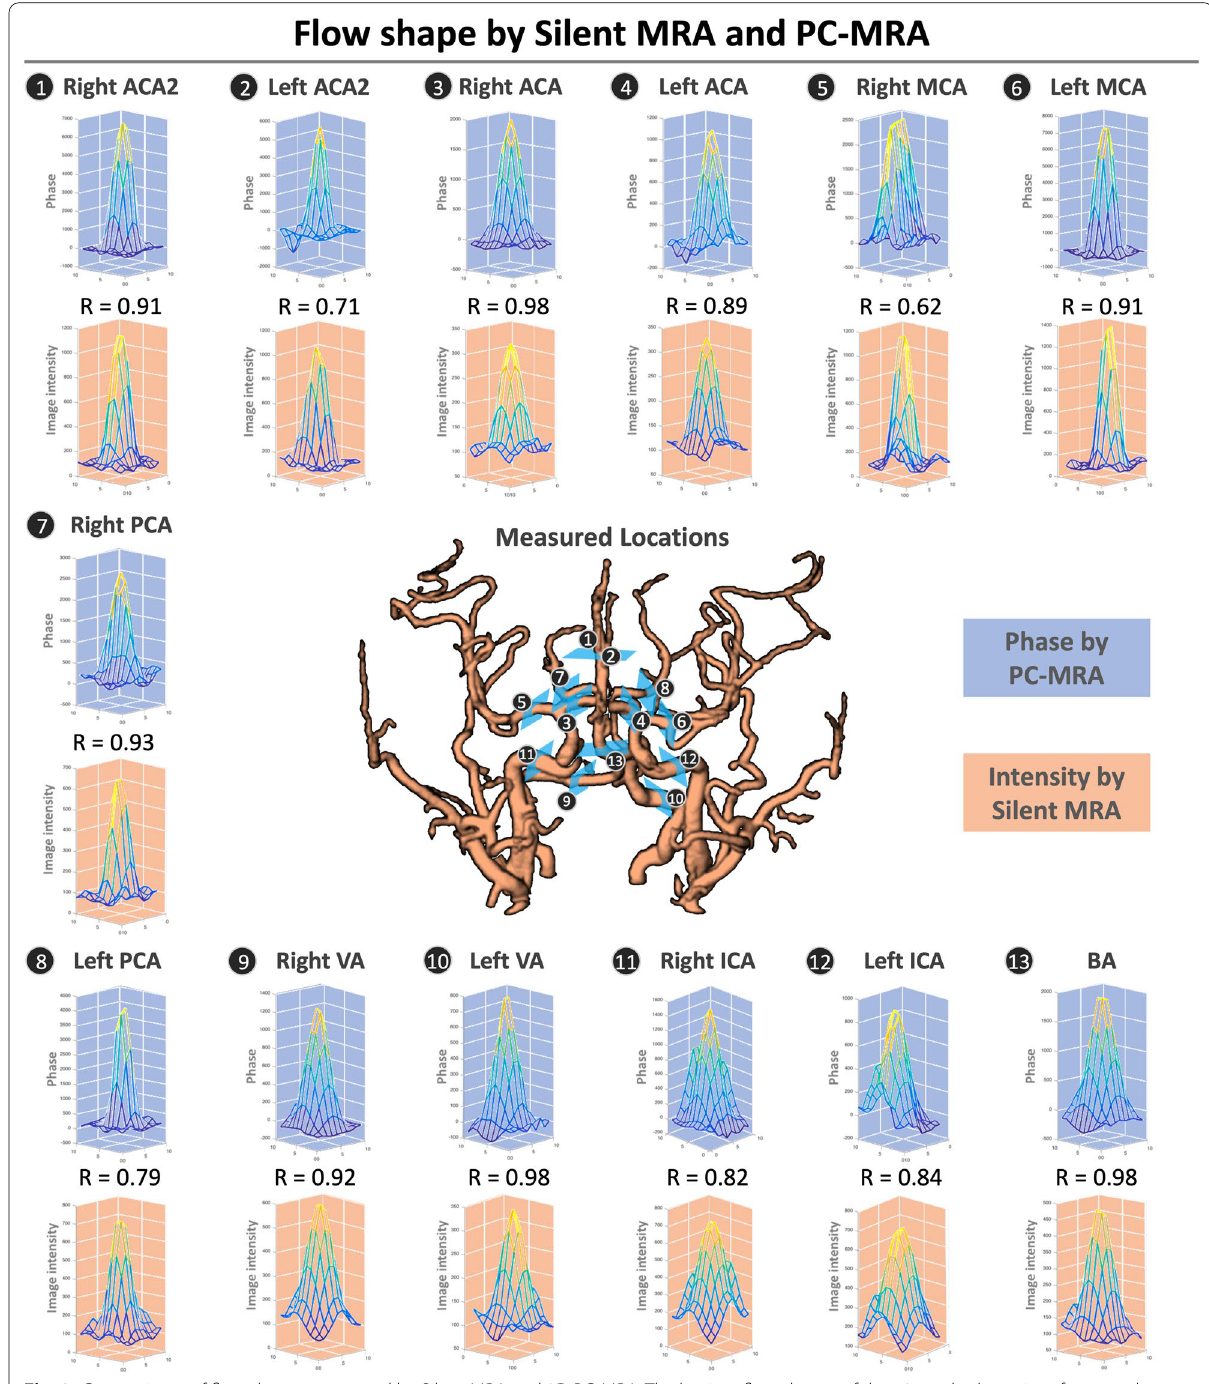
Fig. 3 Comparisons of flow shapes generated by Silent MRA and 2D PC‑MRA. The laminar flow shapes of the 13 cerebral arteries of one study participant (33‑years‑old; man) are similar whether generated by 2D PC‑MRA or Silent MRA. The variable R is the correlation coefficient between the phase distribution (in 2D PC‑MRA) and signal intensity (in Silent